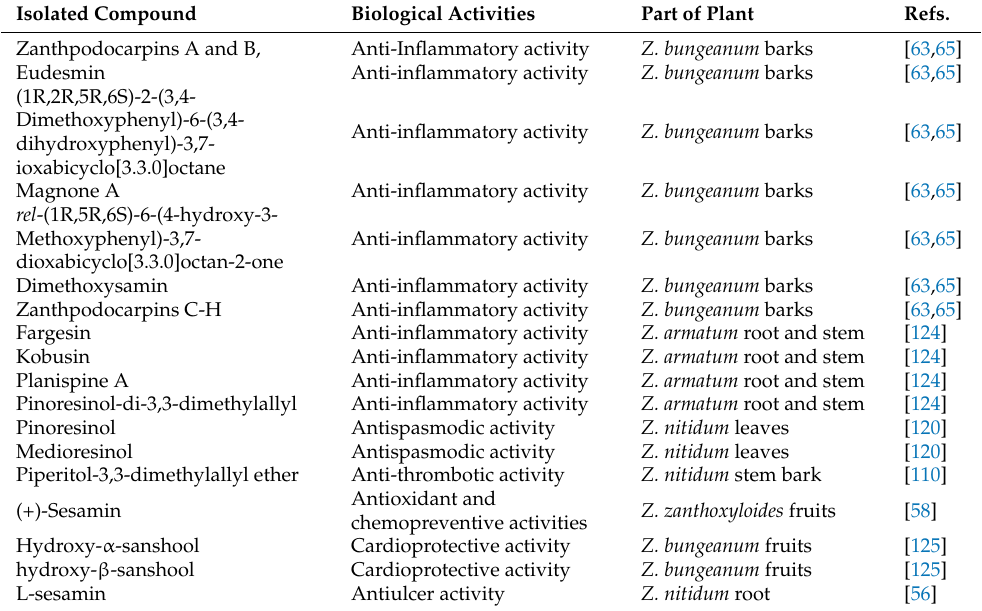
Table 6. Lignans and their derivatives isolated from Zanthoxylum species with anti-inflammatory, antispasmodic, anti-thrombotic, antioxidant, cardioprotective and antiulcer activities.